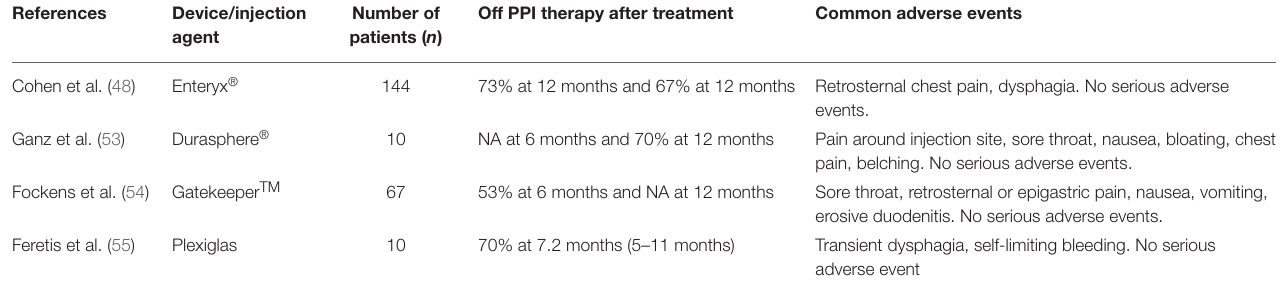
TABLE 3 | Studies with different injectable agents for endoscopic anti- reflux